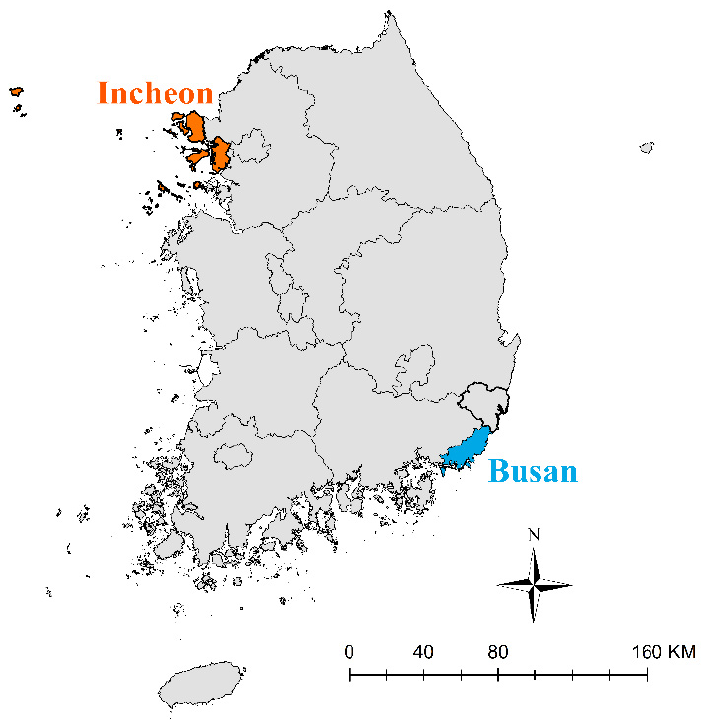
Figure 1. Map of the study areas, Incheon (orange) and Busan (blue). Busan has a population of 3.4 million [30] and is located on the Southeastern tip of the Korean Peninsula (Figure 1). Within the city, discharge from groundwater and contamination have frequently occurred along subway tunnels [31]. On the coastal part, the groundwater along the Suyeong Bay has been reported as being vulnerable to seawater intrusion because the area is composed of sand beaches and reclaimed land [32].